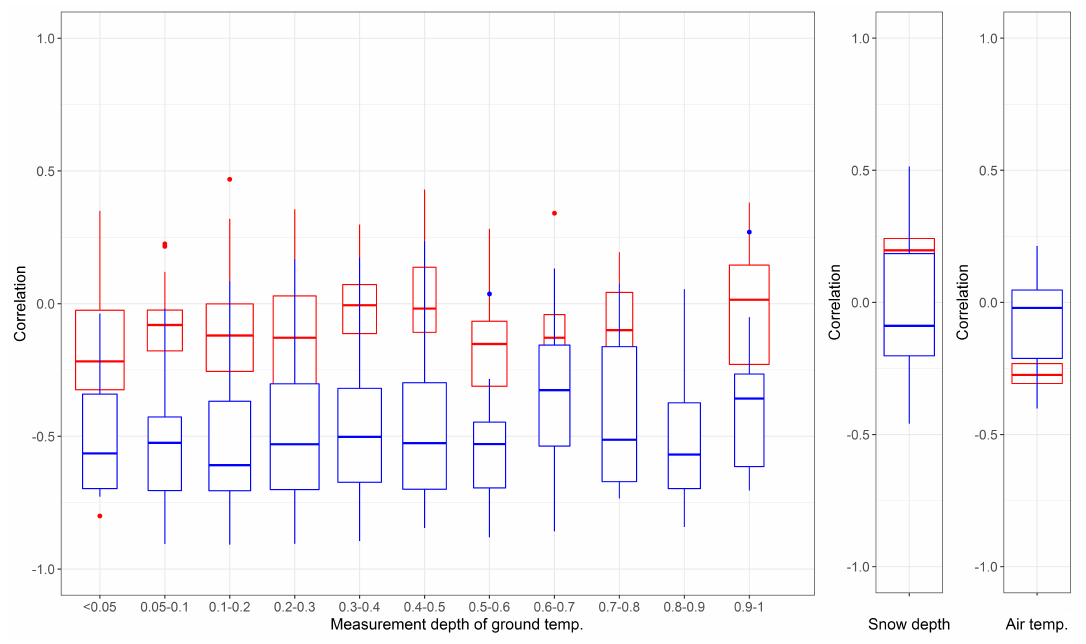
Figure 4. Correlations of ASCAT backscatter values with ground temperature (grouped for different depths (m)), snow depth and air temperature; red and blue represent study sites with freezing degree days above (blue) and below (red) 4000 degree–days, and the variable width of the boxplots represent the relative number of available data points within one group; outliers are represented by the